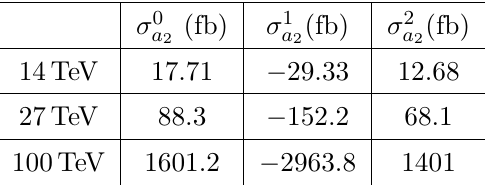
Table 12 . Coefficients σ 0 collider